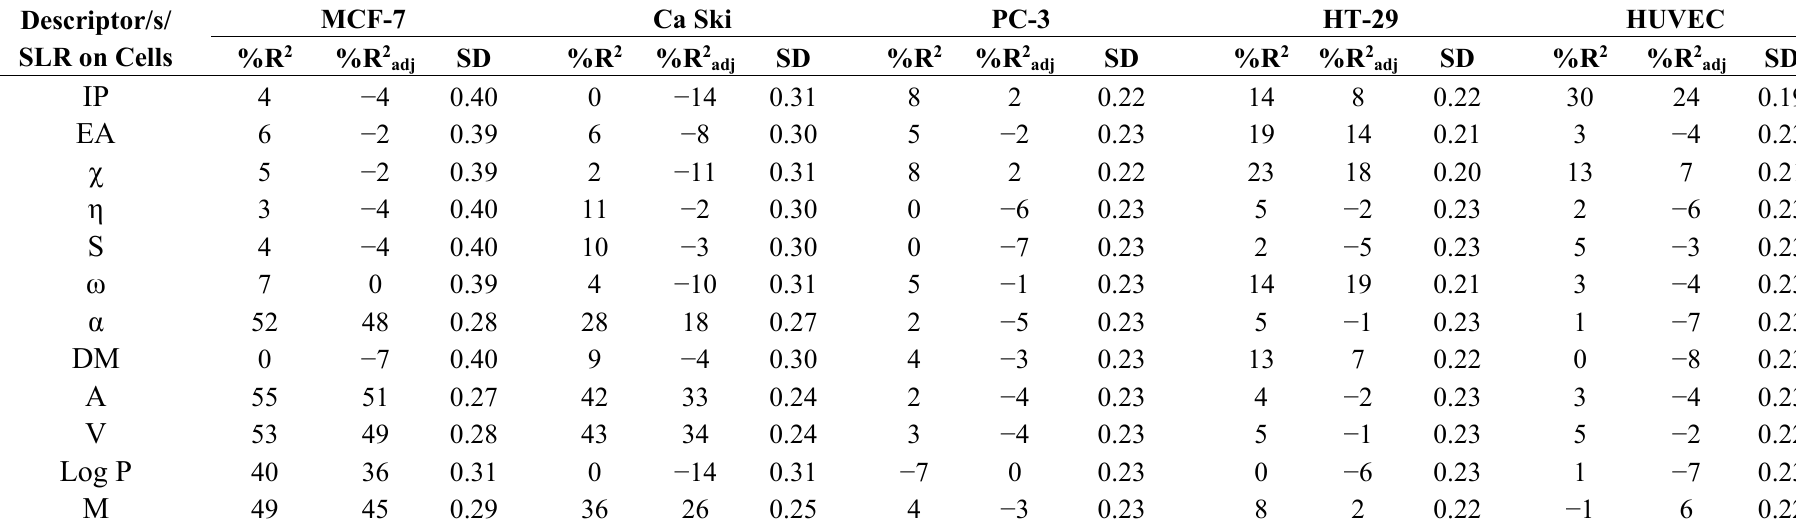
Table 2. Correlation coefficients (R 2 ), adjusted correlation coefficients (R 2 adj ) and standard deviations (SD) of simple linear regression curves (SLR) between each descriptor and the tested cell